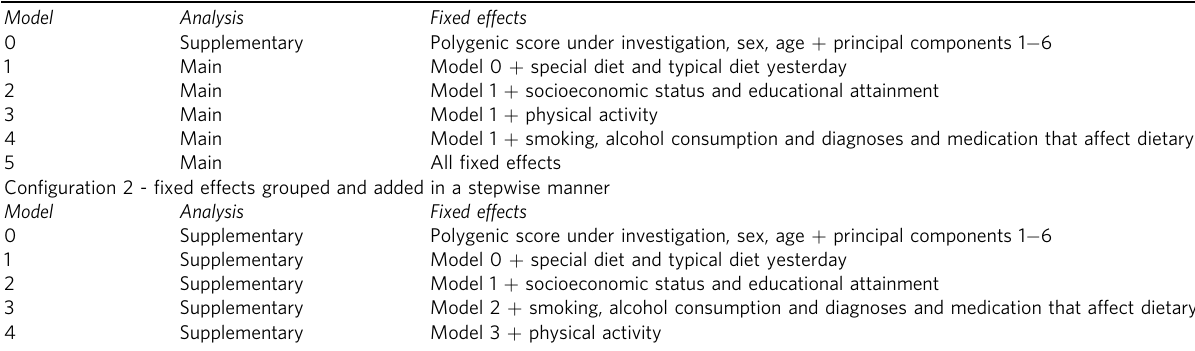
Table 4 Table summarising the fi xed effects included in the linear mixed-effects models. Con fi gurations 1 and 2 represent the models presented in Supplementary Figs. 3/5 and 4/6,